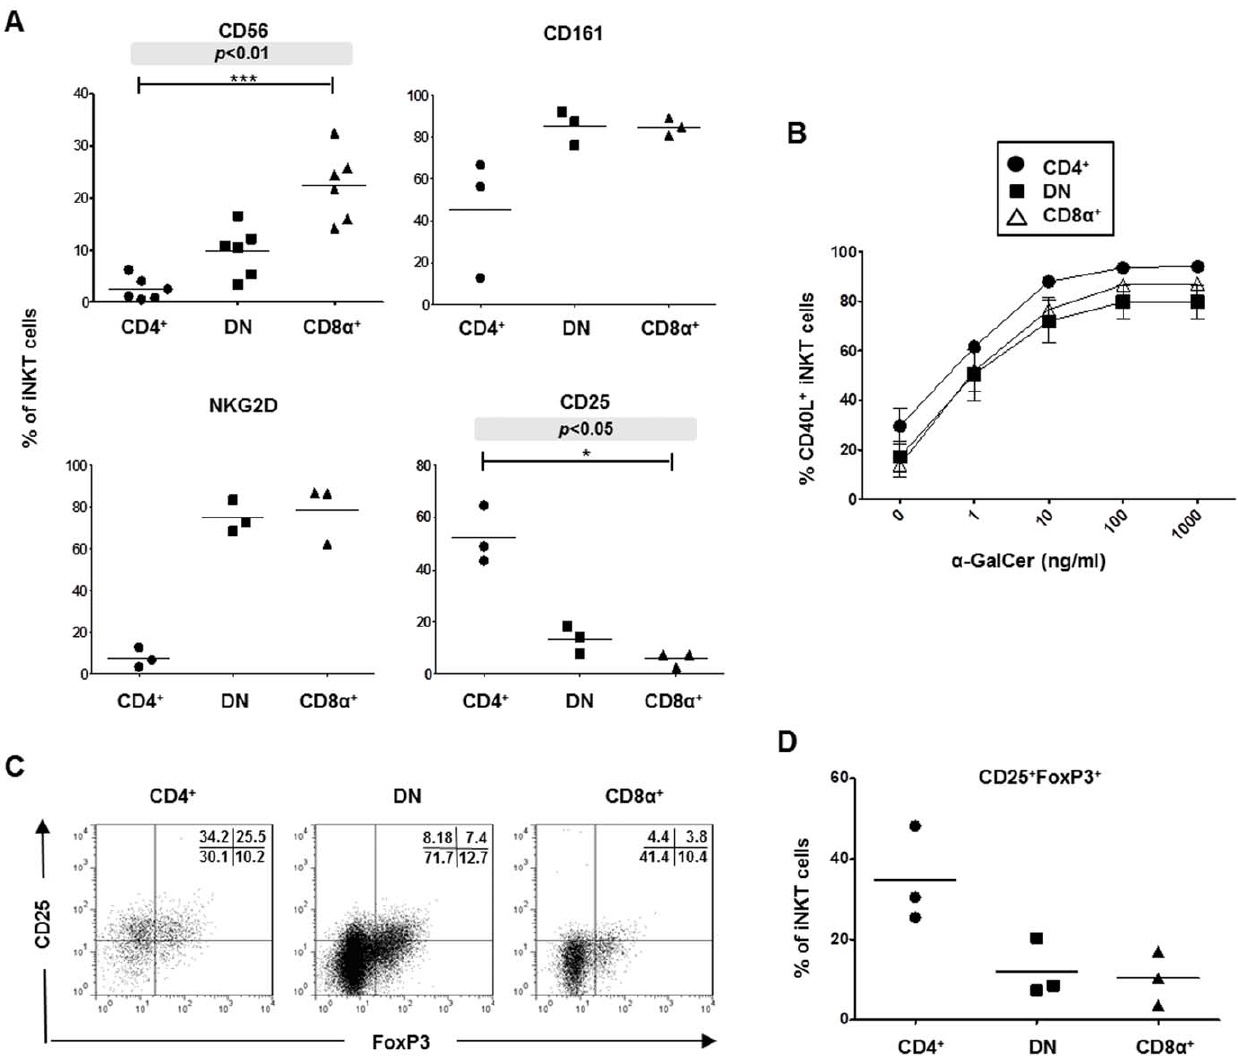
Figure 2. Surface phenotypes of expanded iNKT cell subsets. A, Percentage expression of CD56, CD161, NKG2D and CD25 by electronically- gated CD4 + , CD8 a + and DN cells within expanded iNKT cell lines. Horizontal lines show means; p values in shaded boxes show multiple comparisons of cell frequencies using the Kruskal-Wallis test; asterisks indicate significant differences between individual groups (indicated) using post hoc Dunn’s multiple comparison tests; * p , 0.05; *** p , 0.001. B, Induced cell-surface expression of CD40L by gated iNKT subsets after co-culture of iNKT cell lines with equal numbers of HeLa-CD1d pulsed with various concentrations of a -GalCer. Results show mean ( 6 SEM) percentages of CD40L + iNKT cell subsets within lines from 3 donors. C, Representative flow cytometry dot plots showing cell-surface CD25 and intracellular FoxP3 expression by electronically-gated CD4 + , CD8 a + and DN iNKT cell subsets from 3 donors which were allowed to rest by culturing for 5 days in the absence of IL-2. Quadrants delineating positivity and negativity for CD25 and FoxP3 were set using fluorescence-minus-one control mAb staining, omitting CD25 or FoxP3. Numbers on plots show percentages of cells in each quadrant. D, Frequencies of CD4 + , CD8 a + and DN iNKT cells within 3 iNKT cell lines that express FoxP3 + CD25 + phenotypes.